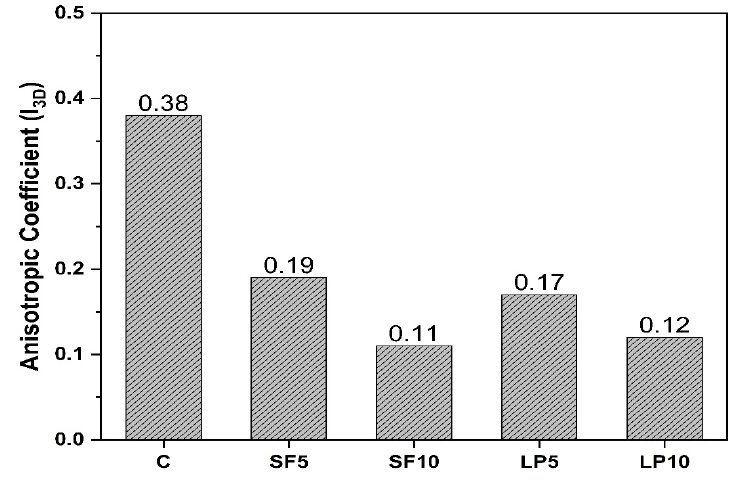
Figure 11. Compressive strength anisotropic coefficient of printable mixtures.